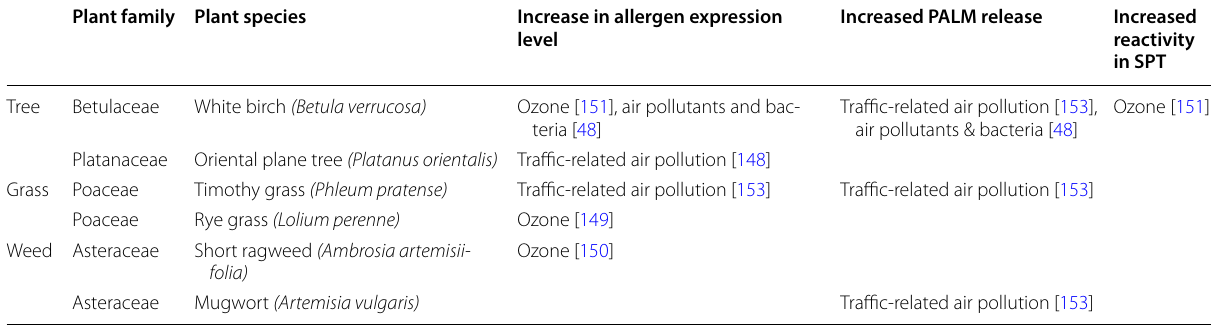
PALMs pollen-associated lipid mediators, SPT skin prick test